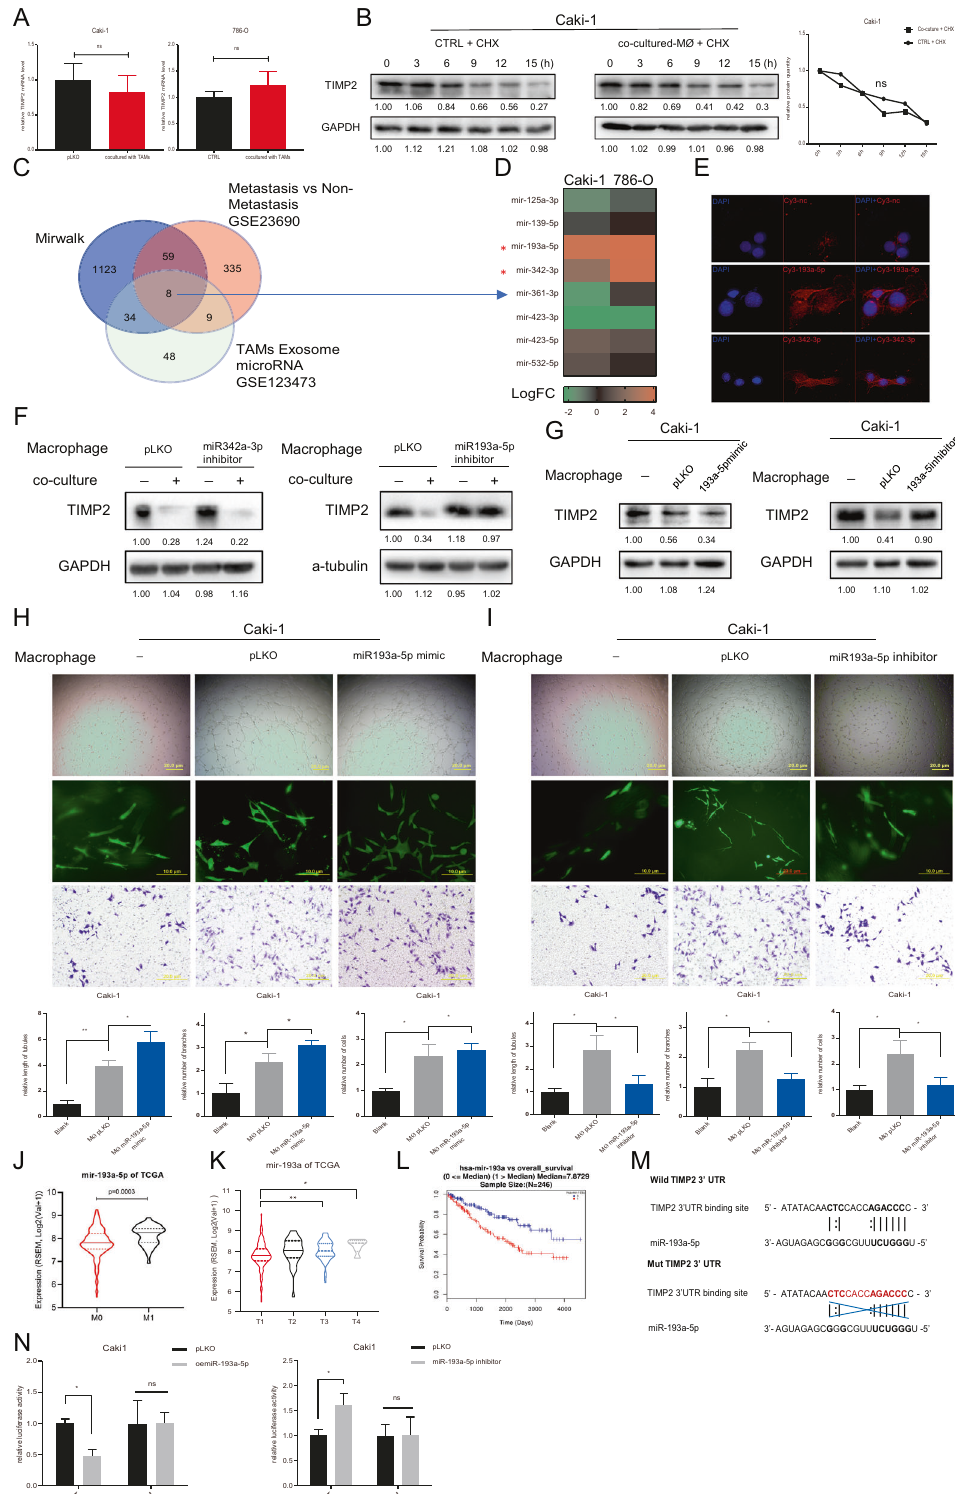
In conclusion, exosome-shuttled miR-193a-5p is transmitted by TAMs to promote VM and cell invasion in RCC, and this newly identi fi ed regulatory pathway can be exploited as a potential therapeutic target to better suppress RCC